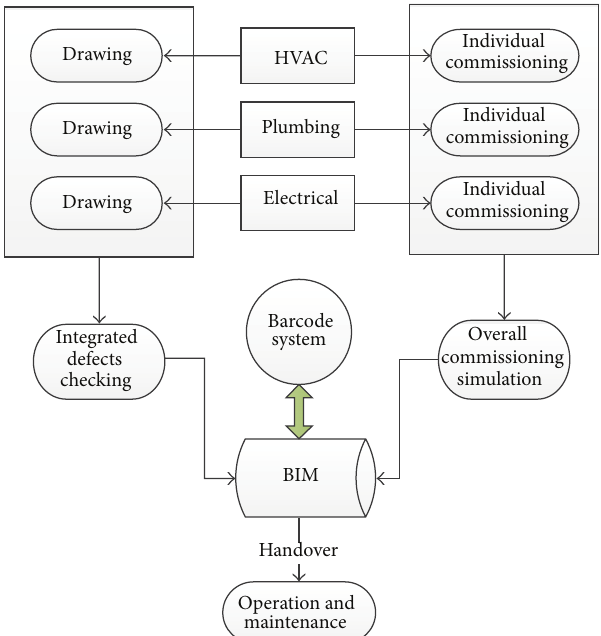
Figure 6: BIM-based commissioning streamline.